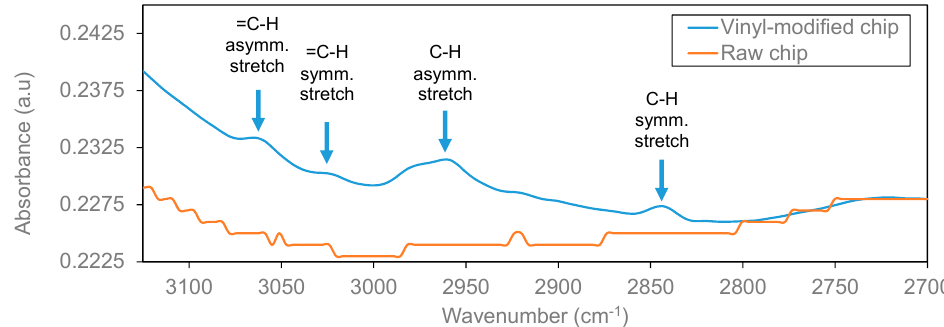
Figure 7. Infrared reflection absorption spectroscopy (IRRAS) characterization results of the SOI chip before and after the TEVS silanization. Bands at 3062 and 3020 cm -1 indicate the presence of vinyl groups.